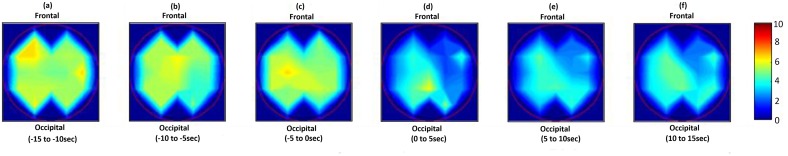
The variations of complexity index (CI) from epoch a to f in patient 1.Each epoch represented mean CI value calculated from 5 sec EEG data points from the pre-ictal state to the ictal state. Changes in mean CI were more prominent over the frontal and central areas during ictal state. The top of the figure was the front of the head and the bottom of the figure was the occipital area of the head. Blue color represented low CI value while red color represented high CI value.